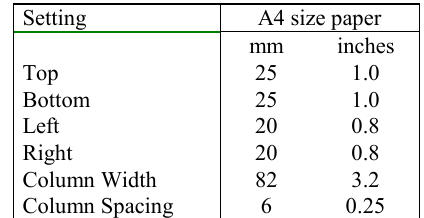
Figure 3. Extracted ridges and the buffered zones in HiRISE image (ESP_018036_1880_RED.jp2). The ridges are first extracted along the crest (top left), and then a buffer with a radius of 10 m is expanded around each ridge (top right). Below shows typical cross profiles of the ridges in the PRP terrain corresponding to the positions in top pannels. And the elevation data is derived from the pair of stereo images of ESP_018036_1880 and ESP_043710_1880.jp2.